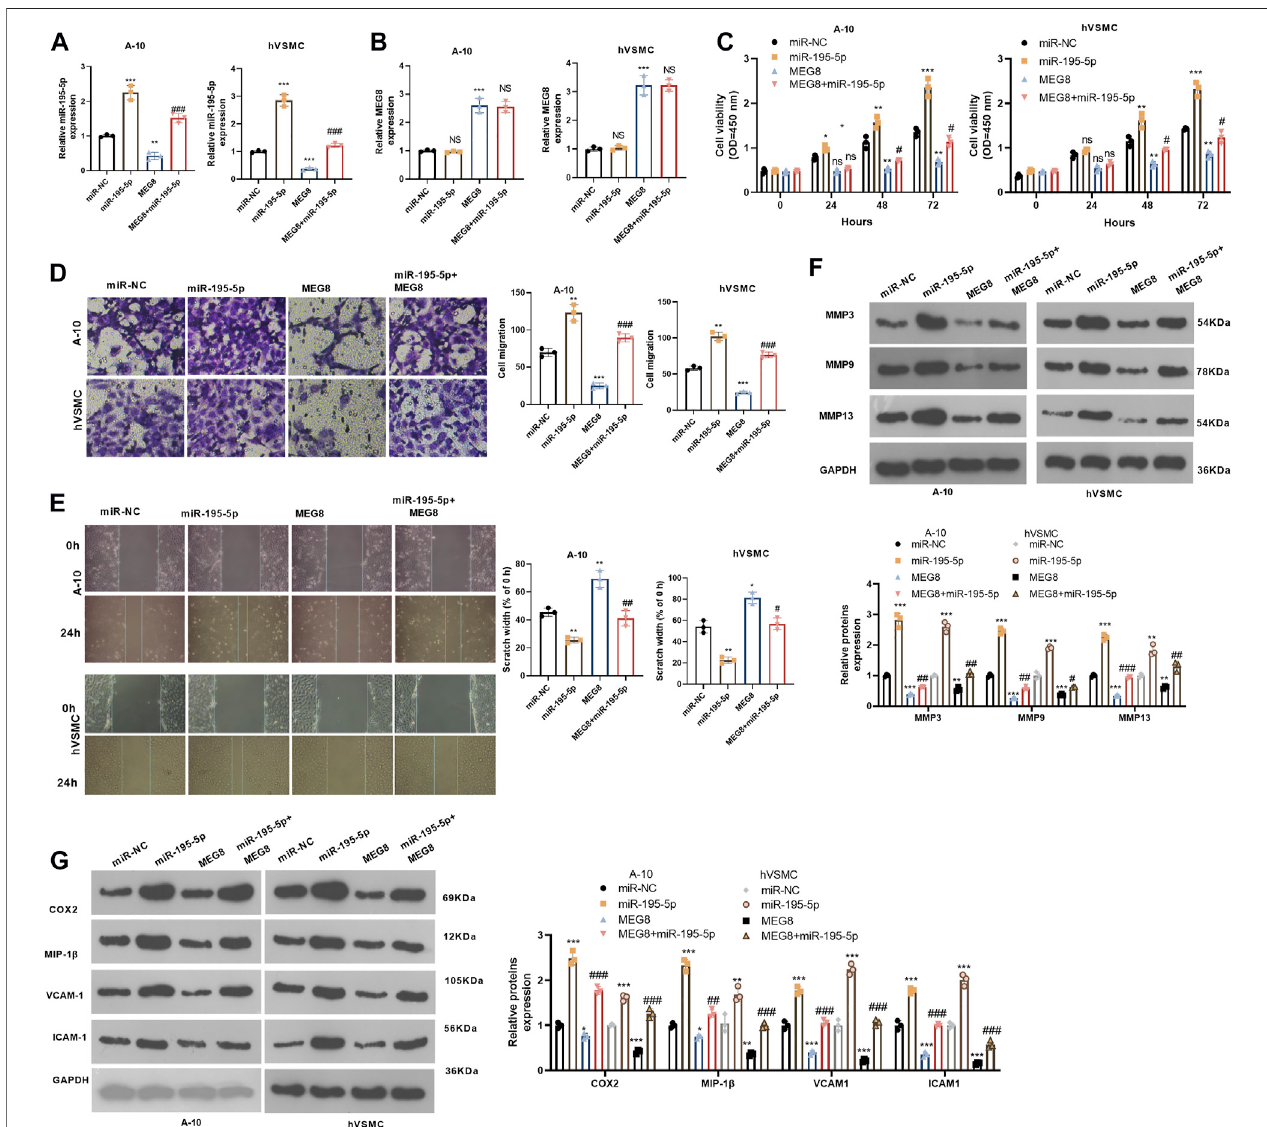
FIGURE 3 | Up-regulating miR-195-5p reversed the protective effect of MEG8 on VSMCs. MEG8 overexpressing plasmids and/or miR-195-5p mimics were transfectedin hypoxia-induced A-10 cellsor hVSMCs. (A,B) Theexpression ofMEG8and miR-195-5p wasmonitored byqRT-PCR.C. Cellproliferationwasmeasured by the CCK-8 assay. (D,E) Transwell and wound healing assays were used to detect cell migration. (F,G) The expression of MMP3, MMP9, MMP13, COX2, MIP-1 β , VCAM-1 and ICAM-1 was analyzed by Western blot. NS p > 0.05, * p < 0.05, ** p < 0.01, *** p < 0.001 (vs. miR-NC group); NS p > 0.05, # p < 0.05, ## p < 0.01, ### p < 0.001 (vs. MEG8 group). All experiments were repeated three times, and each time was performed in